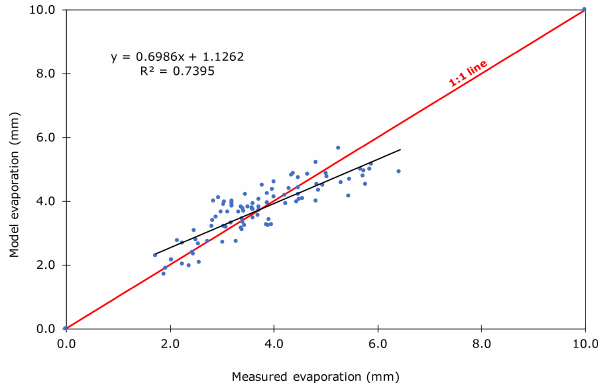
Figure 11. Modelled daily evaporation ( E Res ) versus measured daily evaporation ( E EC ) from June to September